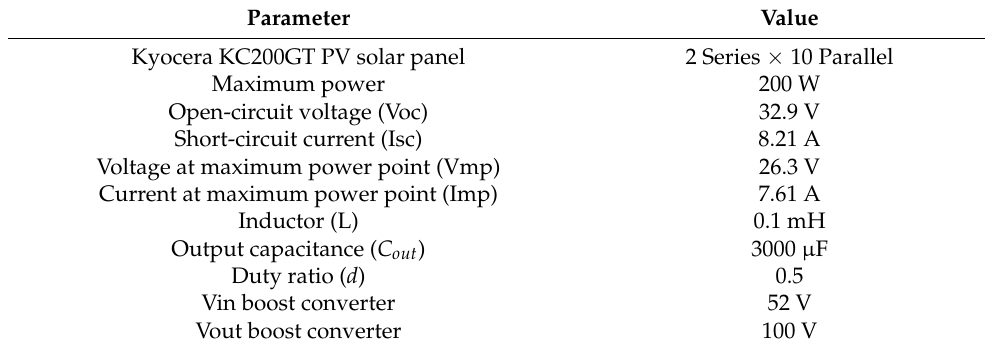
Table 2. PV panel specifications and parameters of the simulated system with boost converters.